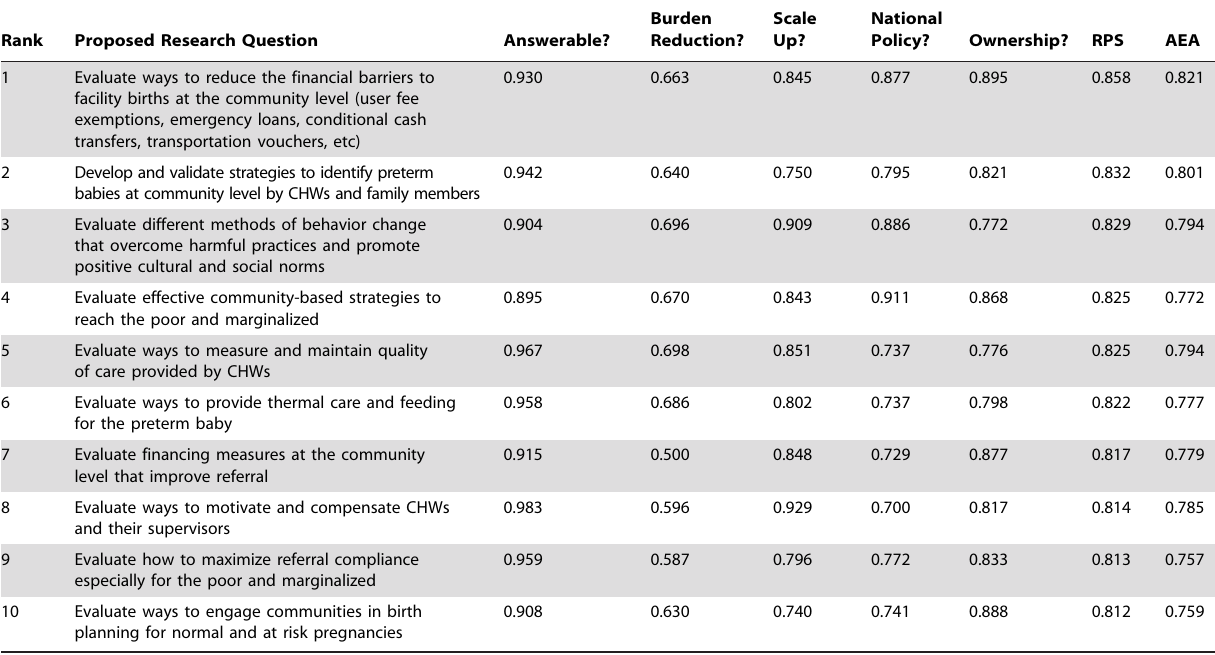
Table 1. The ten research questions that received the highest overall RPS.